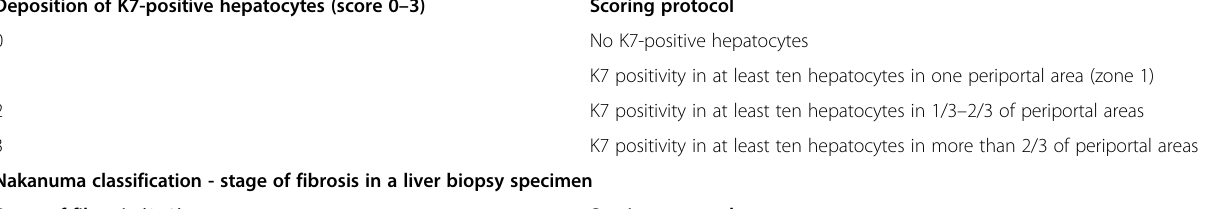
Table 2 Deposition of K7 in hepatocytes in a liver biopsy specimen and stage of fibrosis according to Nakanuma classification. Deposition of orcein-positive granules in Nakanuma classification has been replaced with a similar model, along with applying the deposition of K7-positive hepatocytes in the evaluation of chronic cholestasis. Adapted from [Nakanuma, Y., Zen, Y., Harada, K., Sasaki, M., Nonomura, A., Uehara, T., et al. [19]. Application of a new histological staging and grading system for primary biliary cirrhosis to liver biopsy specimens: Interobserver agreement. Pathology International, 60 (3), 167 – 174,